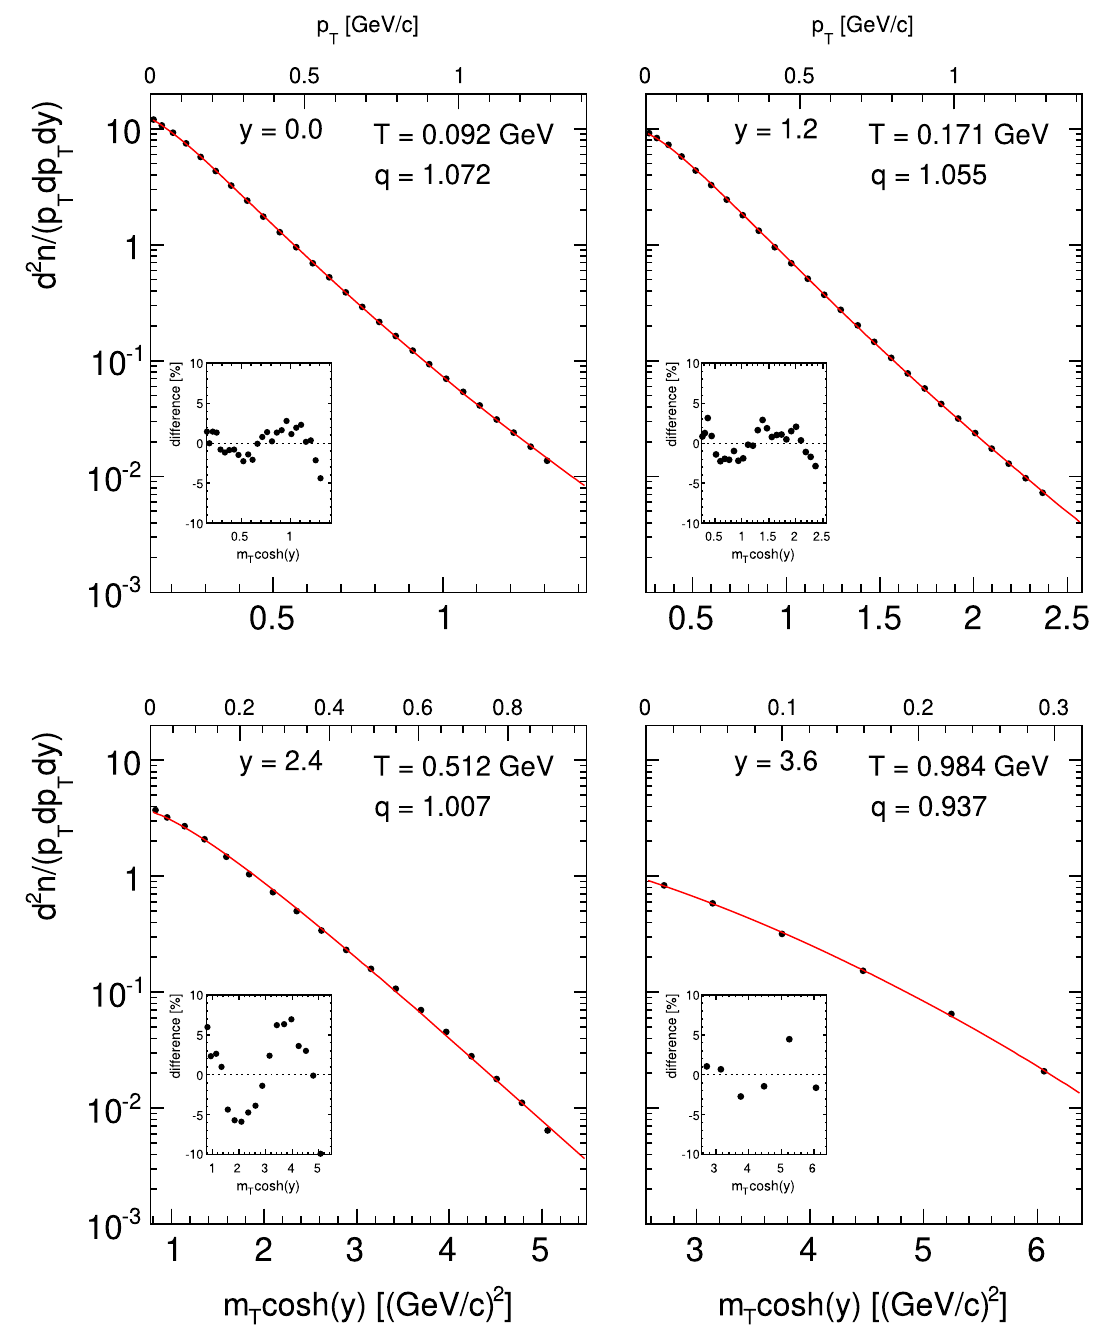
Fig. 145 Tsallis fits of π − cross sections for rapidities between 0 and 3.6 at log s ) = 2.5. The abscissa shows both the quantity m T ∗ cosh ( y ) and p T . For each rapidity the fit parameters T and q as well as the residual distributions of the fits are shown This last panel allows a rather precise check of longitu- in log ( s ) is followed by a further increase at ISR energy. dinal scaling. This concept has been treated in Sect. 12 on This phenomenology does not correspond to a manifestation the double differential level of cross sections. With respect of the down-quark structure function as postulated by some √ s = 17.8 GeV a to the reference line at log ( s ) = 2.5 or models [105,106]. In this context it is regrettable that the far steady evolution of the π − density is evident. The line is forward region is not attainable at the high energy colliders approached from below with increasing energy and a short above the ISR energy plateau between 0.5 and 0.7 in x F and between 2.4 and 2.8